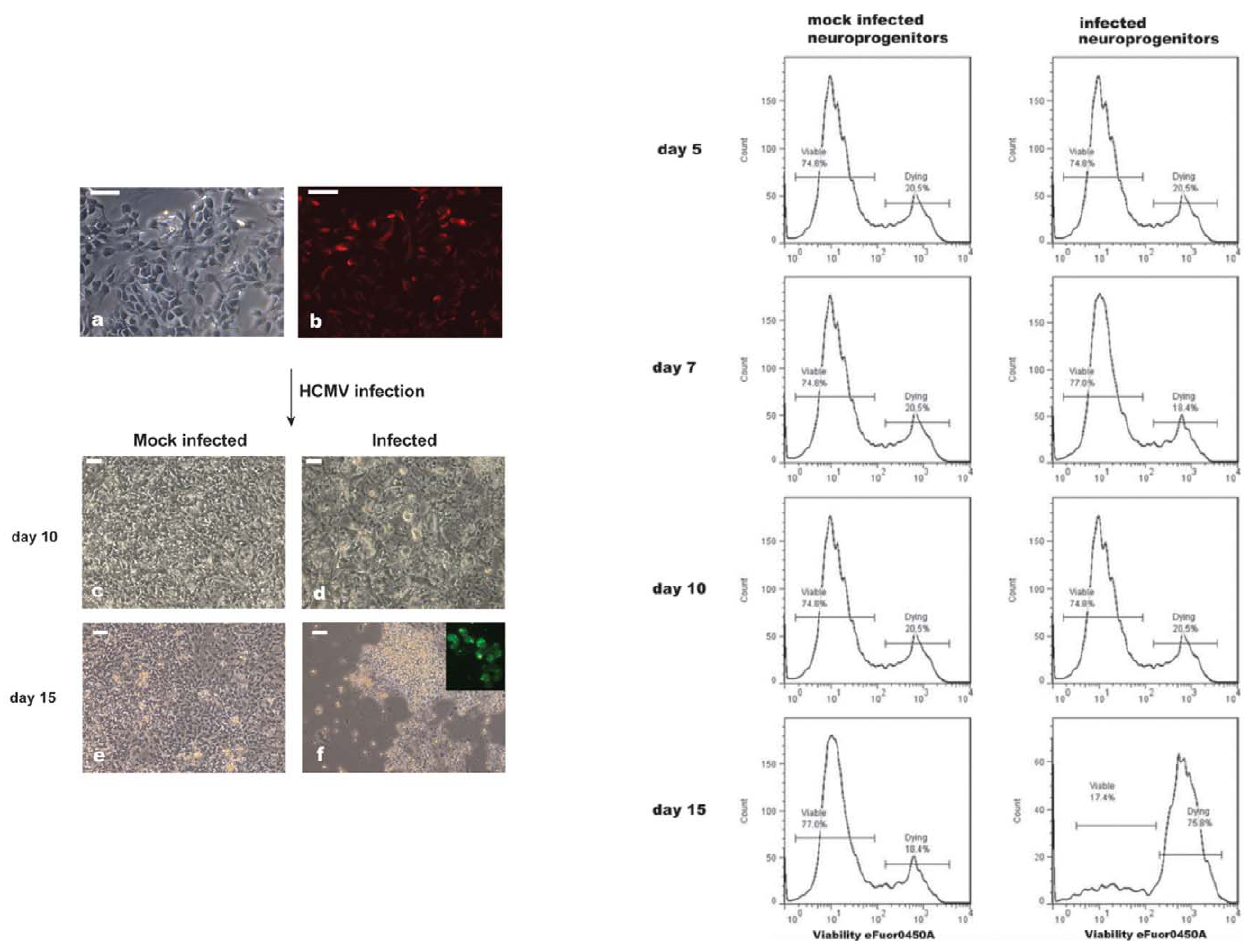
Figure 4. HCMV infection of NPCs. Left panel . (a) microphotograph of NPCs before infection. The percentage of progenitors in the culture approach 90% as showed by staining with nestin (b). Cytopathic effect developed in the infected cultures (d, f). Microphotographs of mock infected NPCs are depicted in (c) and (e). Scale bar is 50 m m. Right panel . FACS analysis of NPCs viability after HCMV infection gated on the nestin-positive cells.